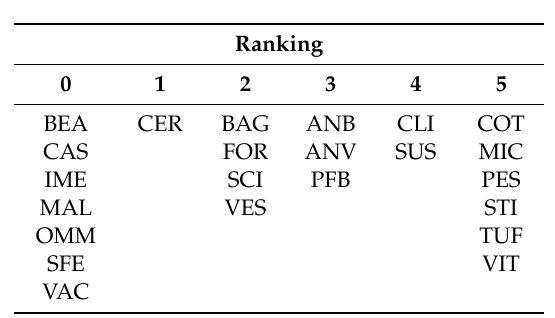
Table 2. Ranking of studied sites following their suitability for the monitoring of neotectonic activity. See main text for